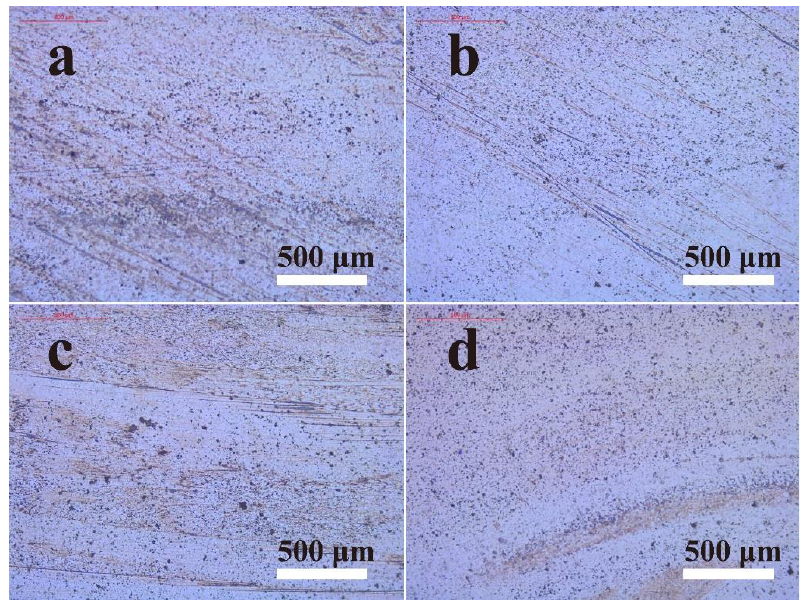
Figure 7. Optical images of the ZrO 2 disk surface after a tribo-acoustic test with various lubricants: